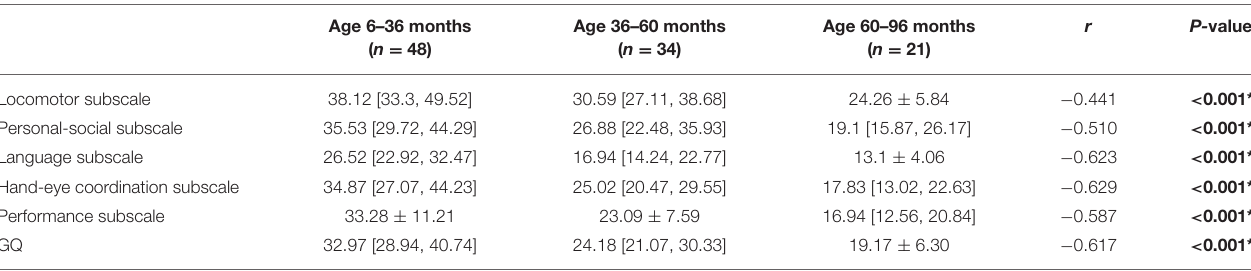
TABLE 2 | Distribution of the subscale quotients for the GMDS-C by age group a